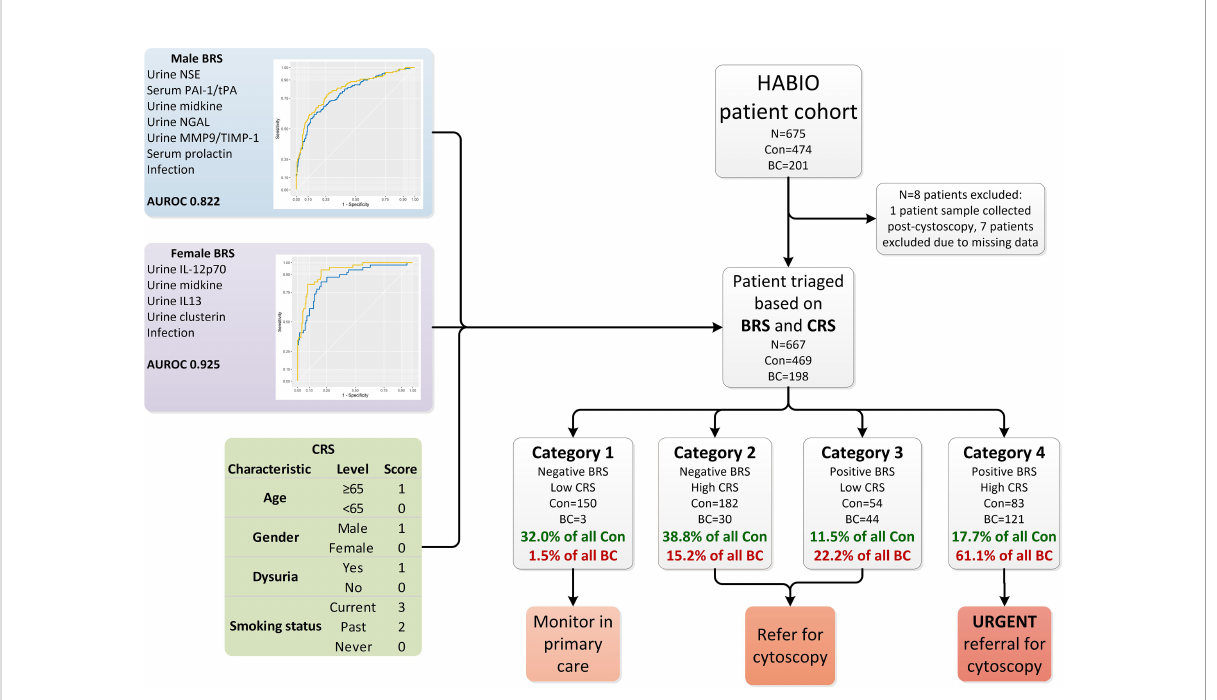
FIGURE 1 Overview of haematuria triage system. The HABIO patient cohort was triaged based on the combination of results from the BRS and CRS into four categories. The biomarkers that contributed to the BRS for males included urine NSE, serum PAI-1/tPA, urine midkine, urine NGAL, urine MMP-9/TIMP-1 and serum prolactin (blue line AUROC 0.795) and with urothelial infection (yellow line AUROC 0.822) is presented in the top left. The biomarkers that contributed to the BRS for females included urine IL-12p70, midkine, IL-13 and clusterin (blue line AUROC 0.865) and with urothelial infection (yellow line AUROC 0.925) is presented in middle left. The CRS is presented in the table bottom left. Con, control; BC, bladder cancer; BRS, biomarker risk score; CRS, clinical risk score; NSE, neuron speci fi c enolase; PAI-1/tPA, plasminogen activator inhibitor-1/ tissue plasminogen activator; NGAL, neutrophil gelatinase-associated lipocalin; MMP-9/TIMP-1, matrix metallopeptidase-9/tissue inhibitor metallopeptidase-1; AUROC, area under receiver operating curve; IL-12p70, interleukin-12p70; IL-13,